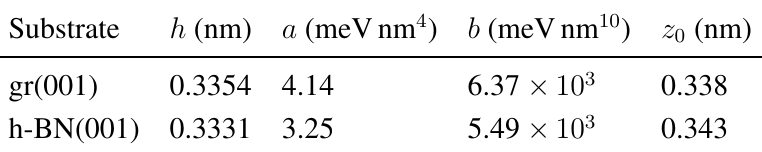
Table A1. Girifalco parameters describing the interaction of a C atom with graphite and hexagonal boron nitride (see